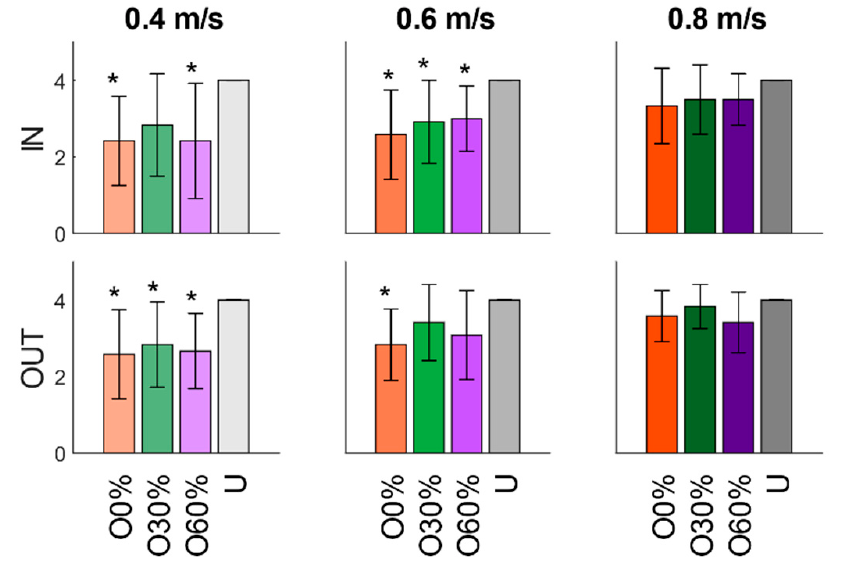
These observations were consistent with the results across subjects. Figures for all subjects and walking speeds can be found in the Supplementary Materials. For walking at 0.8 m/s, all four muscle synergies for perturbed walking were similar to the four muscle synergies for unperturbed walking, regardless of perturbation condition ( r p ≥ 0.623) (Figure 7). Significantly less than four muscle synergies for perturbed walking were similar to the four muscle synergies for unperturbed walking at the lowest walking speed (inwards: p = 0.04 and p = 0.023 for perturbation onsets 0% and 60% of the stance phase of the gait cycle, respectively; outwards: p = 0.009, p = 0.024, and p = 0.003 for perturbation onsets 0%, 30%, and 60% of the stance phase of the gait cycle, respectively).